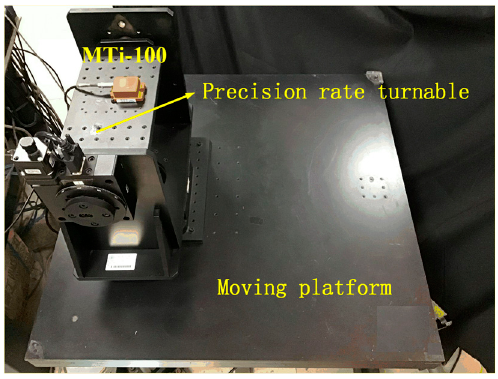
Figure 5. Experimental setup.